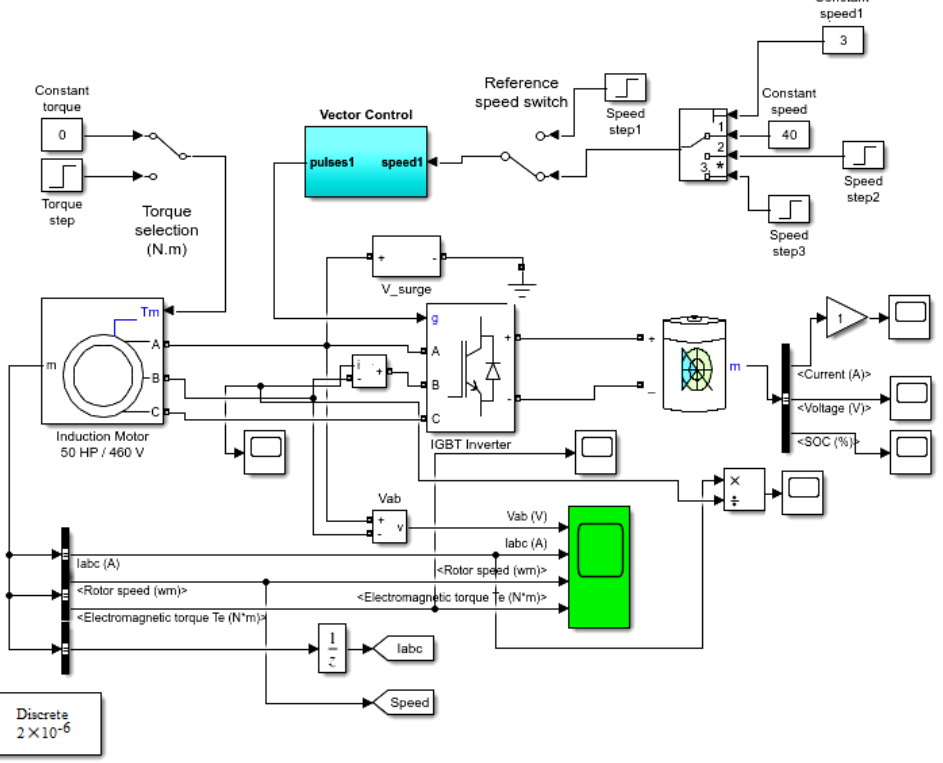
Figure 6. Simulink model of fuzzy logic controller–based vector control.